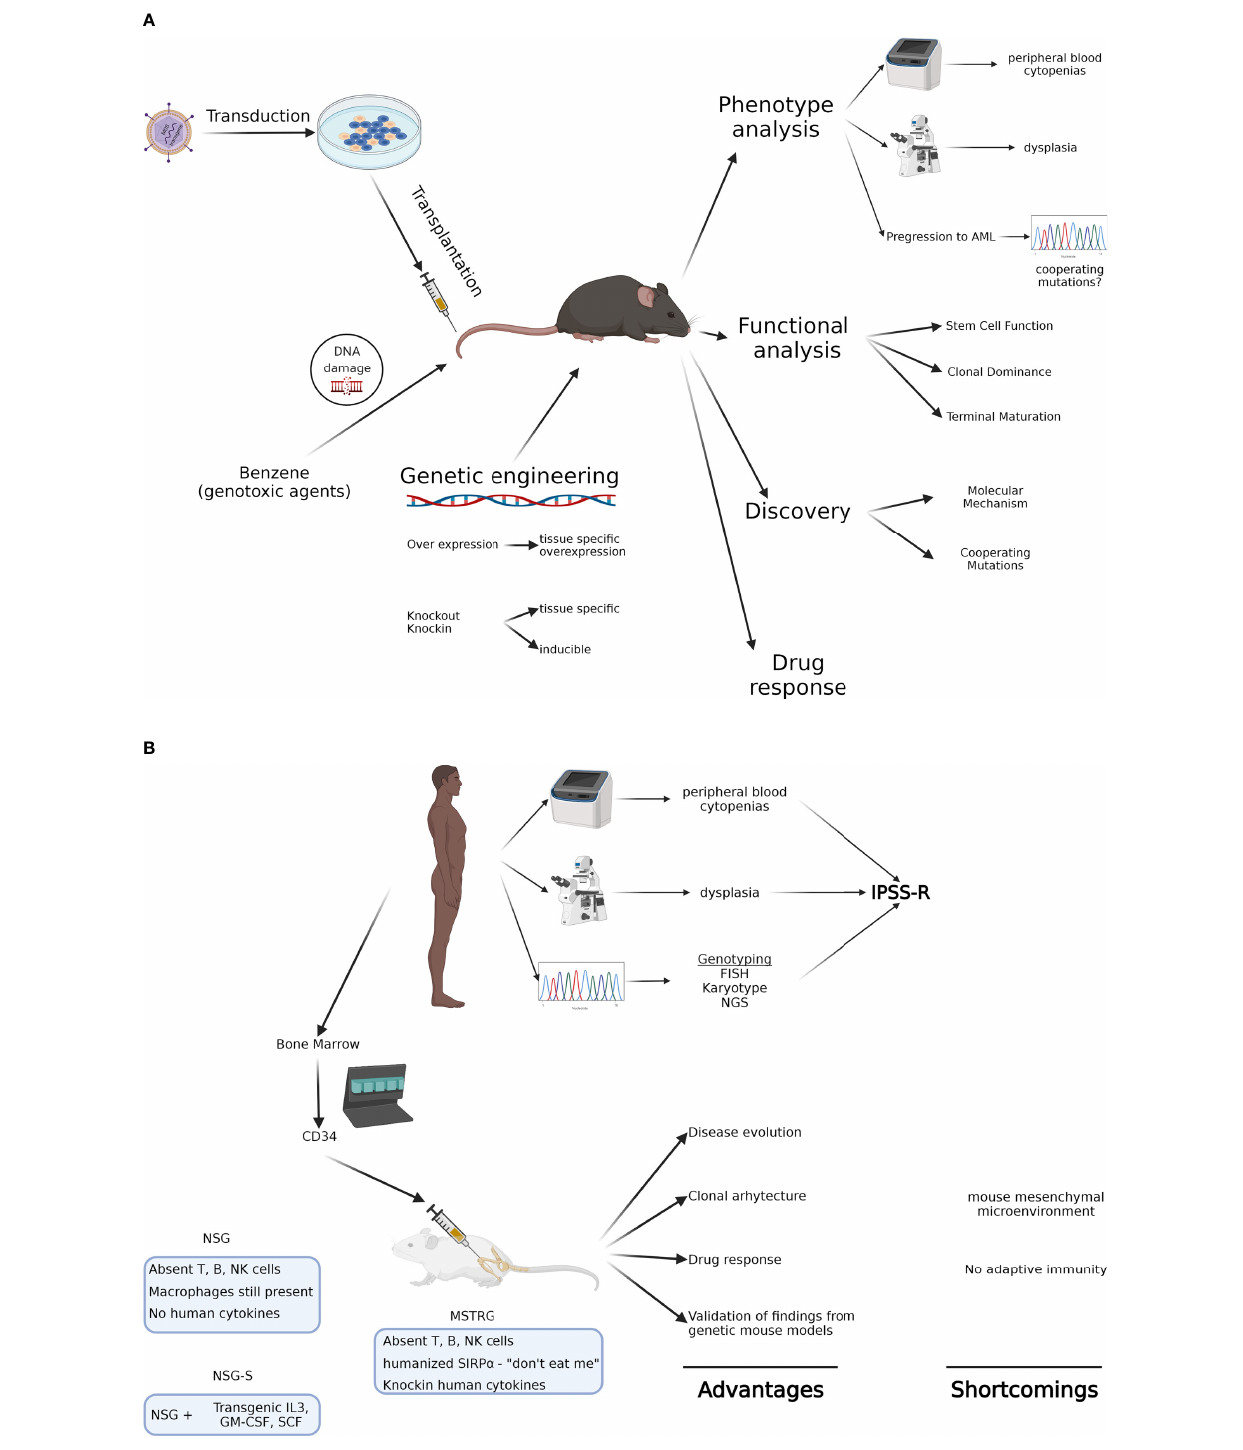
FIGURE 1 | (A) Genetic mouse models of MDS. Using various approaches, these animals allow modeling of MDS in immune competent hosts and in the presence of the endogenous, often unmutated microenvironment. They also provide the analytical tools to study how various mutations impact stem cell function and clonal dominance. Their major shortcoming is that they don ’ t capture the genetic heterogeneity of MDS. (B) Xenograft mouse models of MDS. Using patient-derived MDS cells, these animals allow modeling of genetically complex disease and the study of clonal architecture and clonal evolution. Most recent humanized immunode fi cient mice can even model erythroid maturation, though limited generation of neutrophils and platelets are thus far a major limitation. Created with